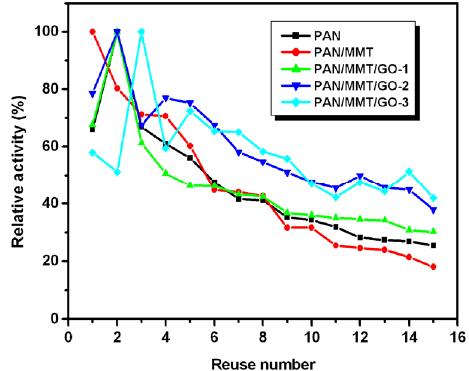
Figure 8. Operational stability of the immobilized laccase on different